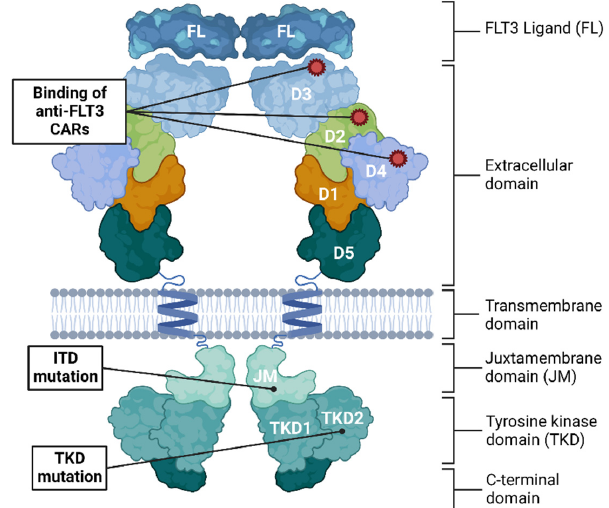
Figure 2. The structure of the FLT3 receptor and the FLT3 ligand (FL). FLT3 consists of an extracellular segment organized in five Ig-like domains (D1-D5), a transmembrane domain with a single helix, a juxtamembrane domain (JM), and two tyrosine kinase domains (TKDs) [55,56]. The FLT3 receptor binds the FLT3 ligand (FL) through interactions with D3 [55]. The FLT3 receptor exists as a monomer until binding of FL, and dimerization of two receptors promotes phosphorylation of the tyrosine kinase, which in turn activates downstream signaling involved in cell proliferation and activation. Phosphorylation is proposed to be controlled by the autoinhibitory effect of the JM [56]. The internal tandem duplications (ITDs) are in-frame duplication or insertion of 3–1236 nucleotides typically situated in the JM [57]. The TKD mutations are mostly caused by point mutations or small deletions and typically situated in the second tyrosine kinase domain (TKD2) resulting in a single amino acid change or deletion [54]. Among the preclinical anti-FLT3 CAR T-cell therapies reviewed here, Chen et al. [31] and Jetani et al. [30] derived their scFv from the anti-FLT3 antibody clone 4G8, reported by Rappold et al. and Hofmann et al. and it binds Domain 4 on FLT3 [58,59]. Li et al. derived their anti-FLT3 scFV from a monoclonal antibody clone EB10, which binds Domain 4 [60]. Maiorova et al. [36] and Wang et al. [34] used the FLT3 ligand instead of a scFv, which binds to Domain 3. Sommer et al. [33] developed nine anti-FLT3 CARs targeting domain 1–5, and the superior constructs, P3A1 and P3E10, bind to Domains 2 and 4 respectively. Karbowski et al. [32] did not detail the binding location of their